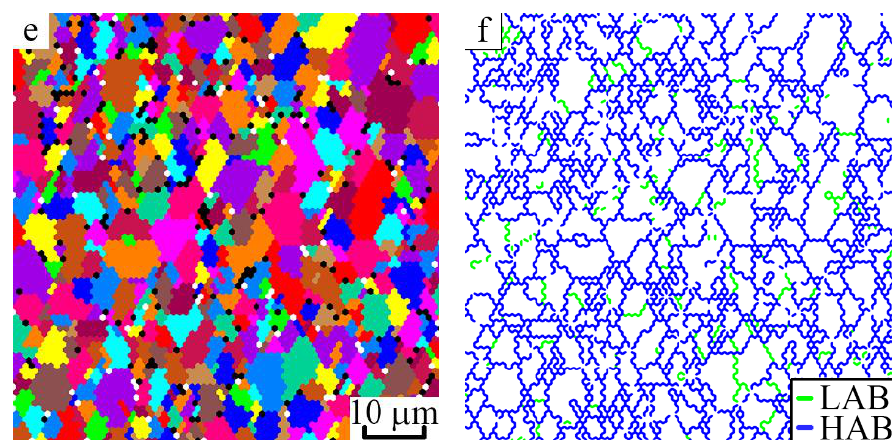
Figure 1. EBSD (electron backscattered diffraction) color-coded grain maps ( a,e ) and grain boundary maps ( b,f ), TEM bright-field images ( c,d ) of V-HNS (high-nitrogen steel) structure after solid-solution treatment ( a–c ), cold rolling with 50% reduction ( d ) and cold rolling with anneal at 1050 °C ( e,f ). EBSD maps in ( a,d ) corresponded to austenitic phase and were constructed with CI > 0.3. Step sizes were 8 µm ( a,b ) and 1 µm ( e,f ). Selected area diffraction pattern in ( c ) corresponded to the (V,Cr)(N,C) particle (inset in c) and was obtained from the area 0.07 µm 2 (marked in yellow circle). LAB—low-angle boundaries, HAB—high-angle boundaries.